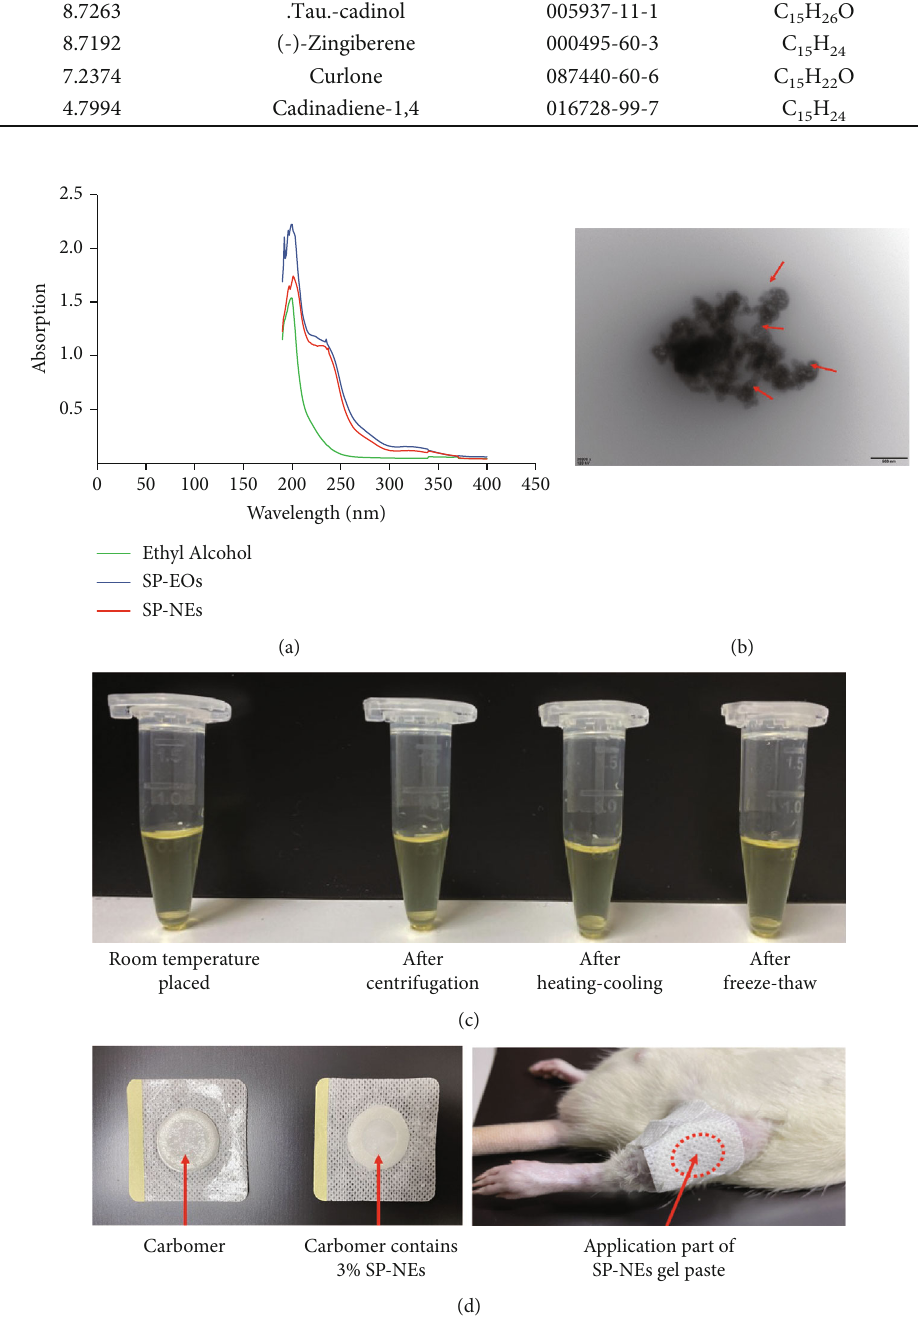
Figure 3: Physicochemical characterization of SP-NEs. (a) Ultraviolet visible spectrum of ethyl alcohol, SP-EOs, and SP-NEs. (b) Transmission electron microscopy observation of SP-NEs, scalebar = 500nm ( × 30000). (c) Visual features of SP-NEs after centrifugation, heating – cooling, or freeze-thaw. (d) Carbomer gel with 3% SP-NEs and its external